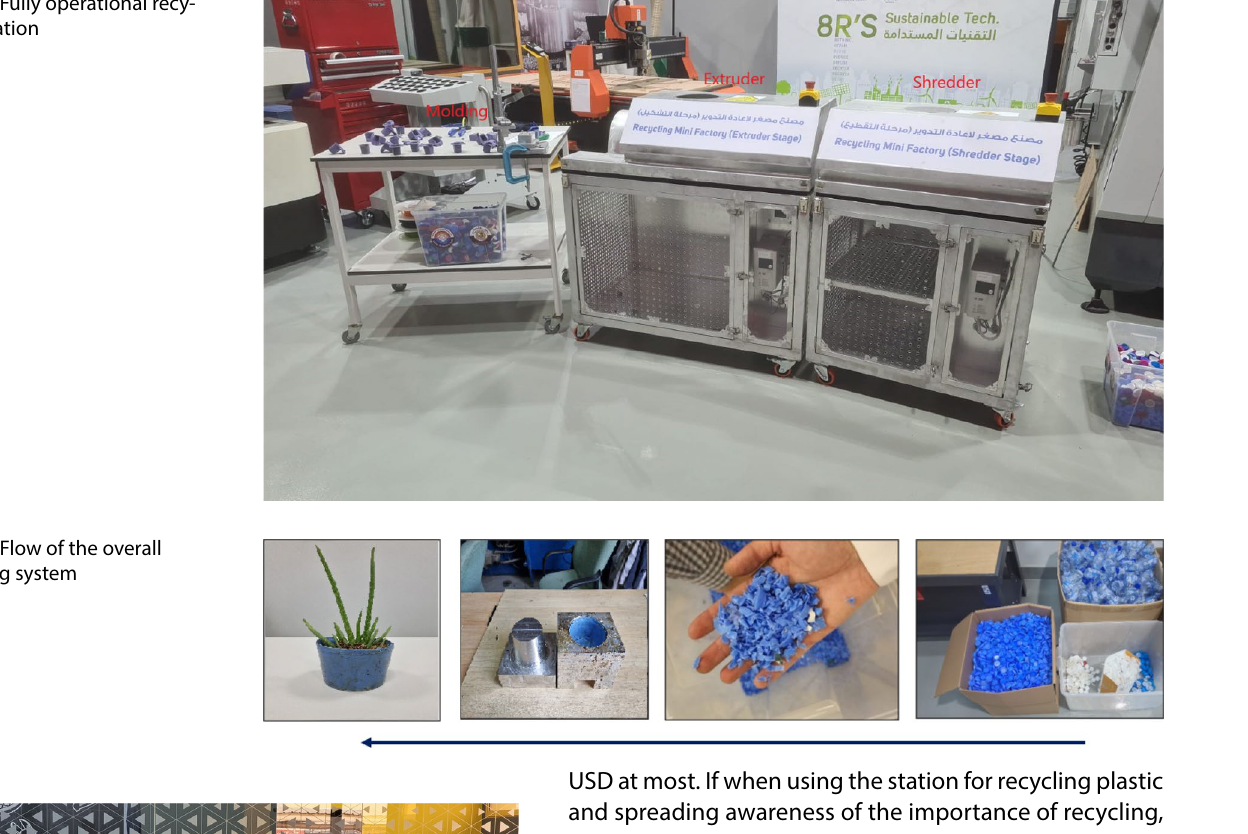
Fig. 22 Fully operational recy- cling station